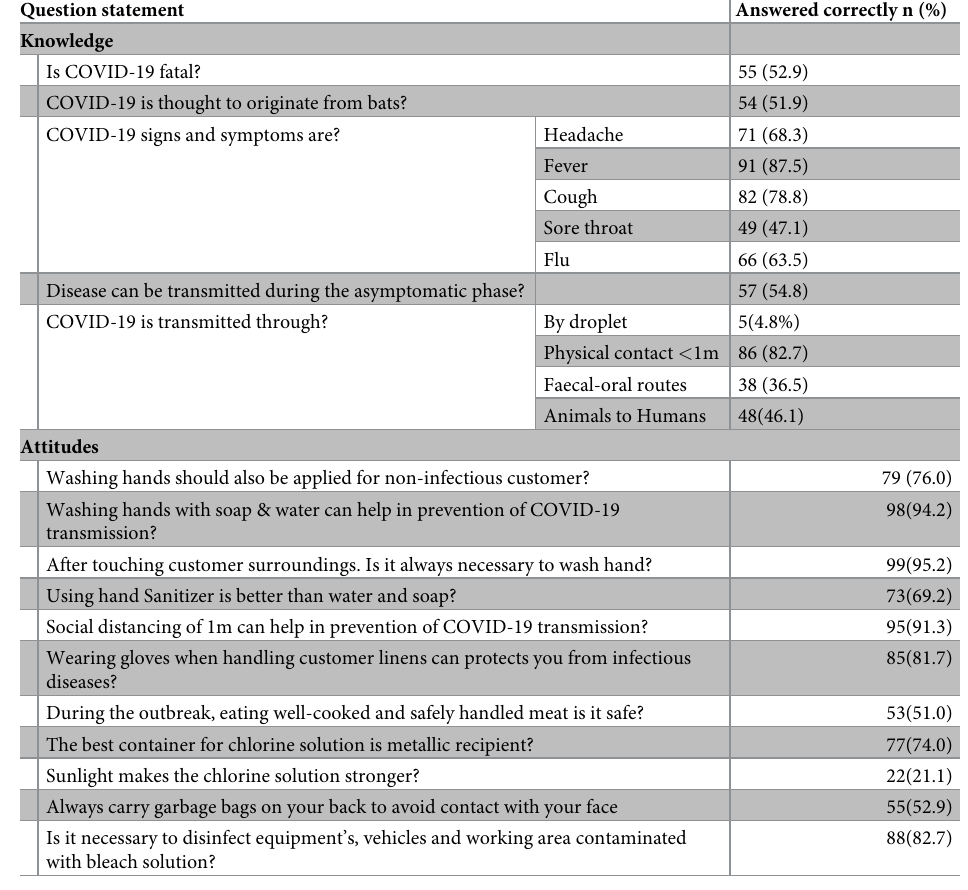
Table 2. Distribution of correct answers on baseline evaluation of knowledge and attitudes on COVID-19 among hotels’ staff in Kigali (N =